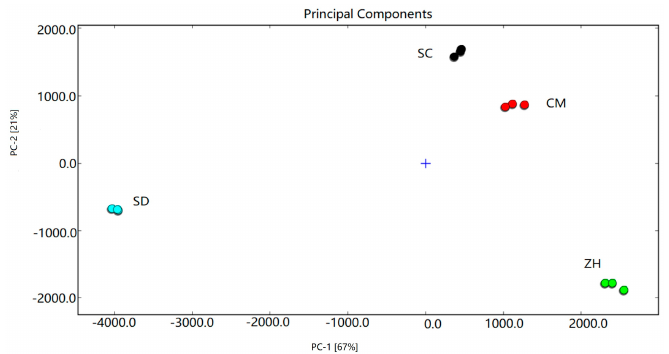
Figure 3. PCA analysis of Cui Guan pear samples with different regions. Figure 3 . PCA analysis of Cui Guan pear samples with different regions .